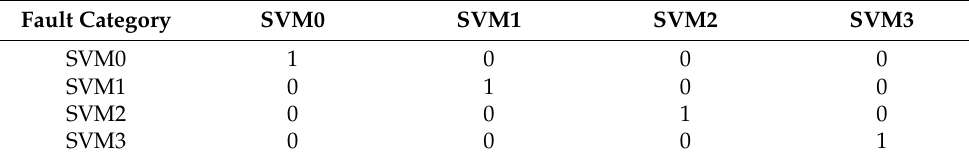
Table 2. Sample identification method of four kinds of adjustment